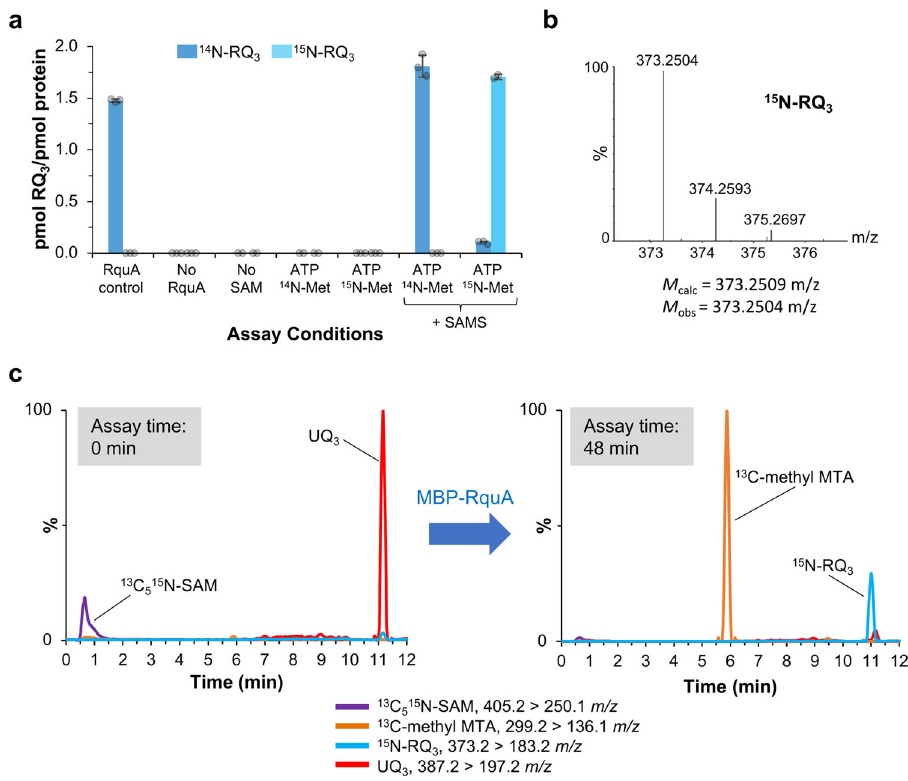
Fig. 4 SAM is the amino donor for RQ biosynthesis. a In vitro assays were performed with commercially available S -adenosyl- L -methionine (SAM, 5 μ M) or a SAM synthetase (SAMS) reaction mixture containing ATP and 14 N- L -methionine or 15 N- L -methionine. Cleaved RquA (0.5 μ M) and ubiquinone-3 (UQ 3 , 5 μ M) were used with assay conditions described previously. Production of 14 N-rhodoquinone-3 ( 14 N-RQ 3 ) and 15 N-RQ 3 are shown as dark and light blue, respectively. n = 3 independent experiments and error bars represent the standard deviation of the mean. b The mass of synthesized [ 15 N-RQ 3 + H] + was determined to be 373.2504 m/z (C 23 H 34 15 NO 3 exact mass = 373.2509 m/z , mass accuracy = − 1.4 ppm). The full mass spectrum is presented in Supplementary Fig. 11. c Puri fi ed 13 C 5 15 N-SAM (5 μ M), MBP-RquA (0.5 μ M), and UQ 3 (5 μ M) were used in an assay at pH 6. Four multiple reaction monitoring transitions ( 13 C 5 15 N-SAM: purple, 13 C-methylthioadenosine (MTA): orange, 15 N-RQ 3 : blue, UQ 3 : red) were monitored during the assay as outlined above. The response factor for MTA is approximately four times greater than RQ 3 and 100 times greater than SAM under these chromatography conditions. Peak intensities were normalized out of 100%, based on the largest peak in each chromatogram.